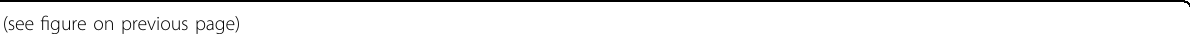
Fig. 5 De fi ciency of PRDX2 augments the activity of MMPs and oxidative stress in Ang II-induced AAA. Analysis of abdominal aortas from Prdx2 + / + and Prdx2 − / − mice infused with saline or Ang II for 4 weeks. a Representative in situ zymography images and b quanti fi cation using cross- sectioned abdominal aortas (saline groups, n = 3; Ang II groups, n = 5 – 6). Scale bar, 50 µm. Data are presented as the mean ± SEM (two ‐ tailed Student ’ s t test). c Immunoblotting analysis of MMP2, MMP9, fi bronectin, collagen IV, and PRDX2 in aortas from Prdx2 + / + and Prdx2 − / − mice infused with saline or Ang II for 4 weeks. β -actin was used as a loading control. d Quanti fi cation of MMP2 and e fi bronectin in Fig 5 c . Data are presented as the mean ± SEM (two ‐ tailed Student ’ s t test). f Representative confocal images of DHE staining in abdominal aortic cross-sections. Scale bar, 50 µm. g Immunoblotting analysis of 4-HNE in aortas from Prdx2 + / + and Prdx2 − / − mice infused with saline or Ang II for 4 weeks. β -actin was used as a loading control. h Representative immunostaining images of 4-HNE (left) and 8-OHG (right) in abdominal aortic cross-sections. Low magni fi cation images (scale bar, 200 µm) and higher magni fi cation of the boxed area (scale bar, 100 µm). Nuclei were stained with